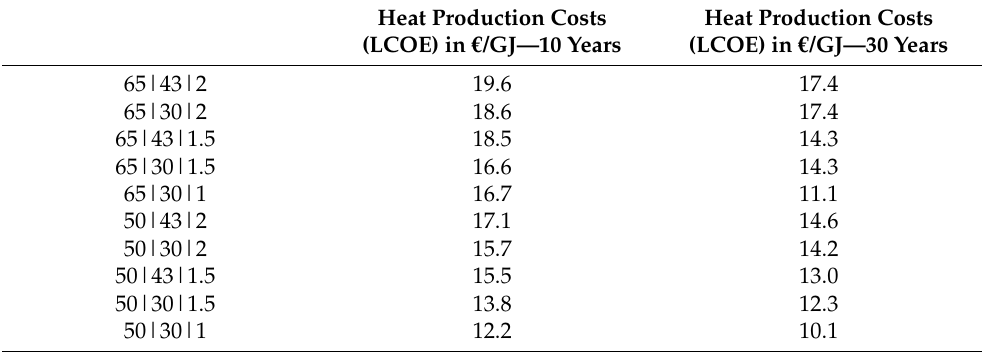
Table 7. LCOE analysis with 30 years of operation of the heat pump/HT-ATES